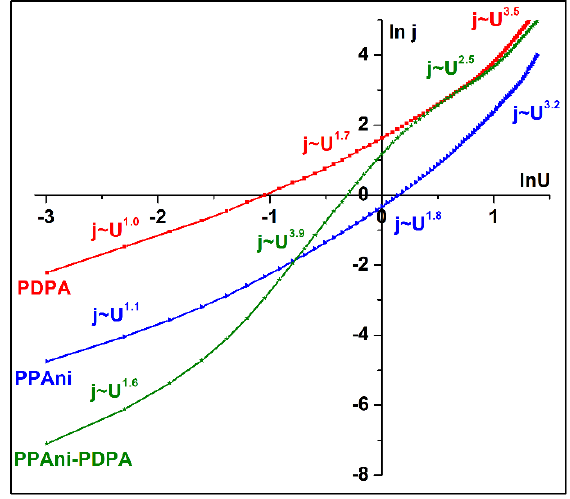
Figure 13. lnj vs. lnU plots for PPAni, PDPA, and PPAni-PDPA films.